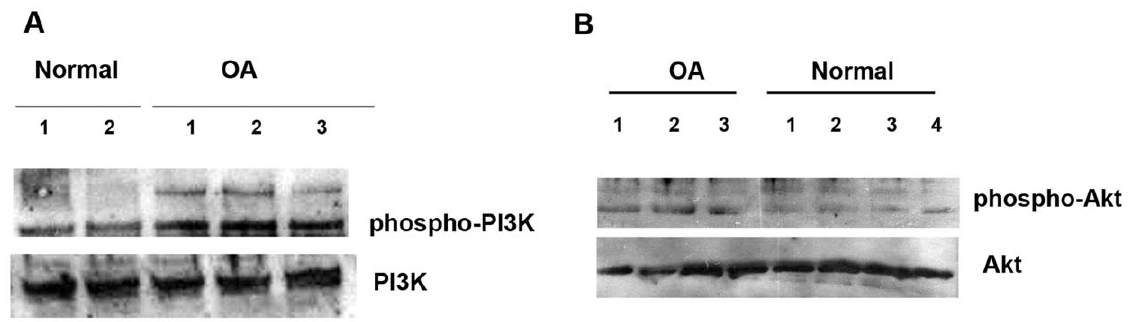
Figure 2. Phospho-PI3K and phospho-Akt expression in normal and osteoarthritic chondrocytes. ( A ) A representative western blot showing phospho-PI3K protein expression level in normal and osteoarthritic chondrocytes. Total PI3K expression level is shown in the lower panel. ( B ) A representative western blot showing phospho-Akt protein expression level in normal and osteoarthritic chondrocytes. Total Akt expression level is shown in the lower panel.